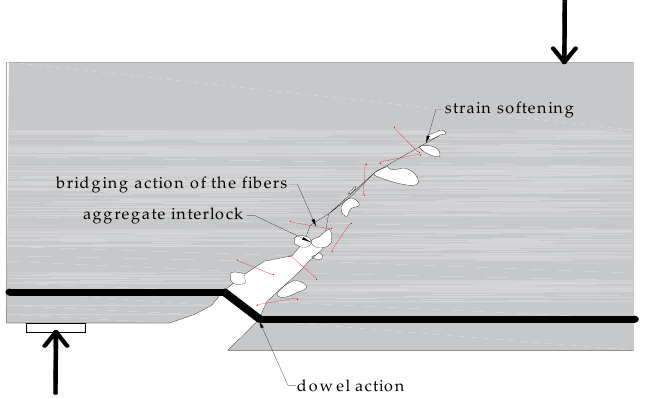
Figure 1. Mechanisms of shear force transmission + fiber influence (own elaboration).